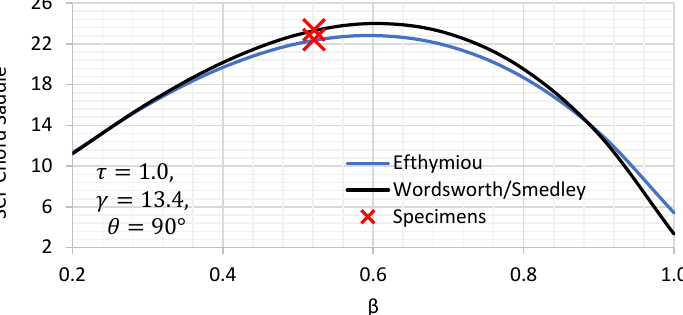
Figure 2. Axially loaded DT joints: chord SCF variation with 𝛽 for a set of joint parameters ( 𝜃 , 𝛾 and 𝜏 ).